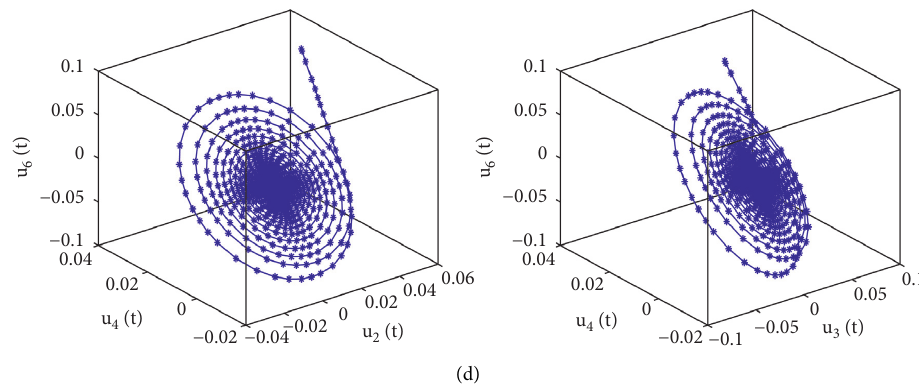
Figure 1: Stability property for neural network model (46) involving ζ � 0 . 65 < ζ